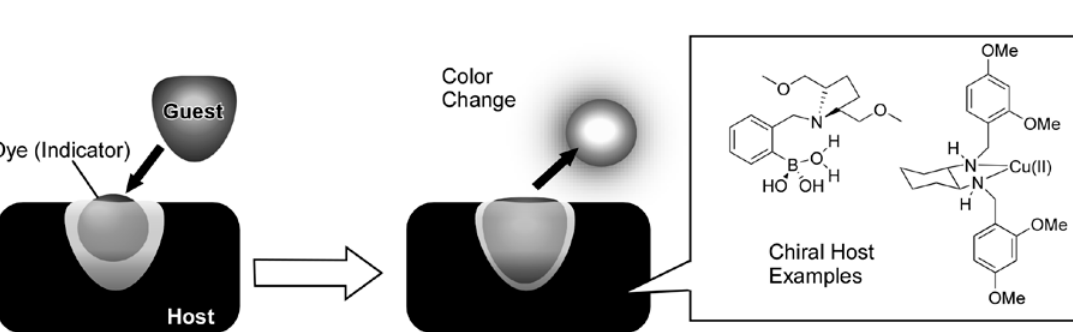
Figure 1. Indicator-displacement